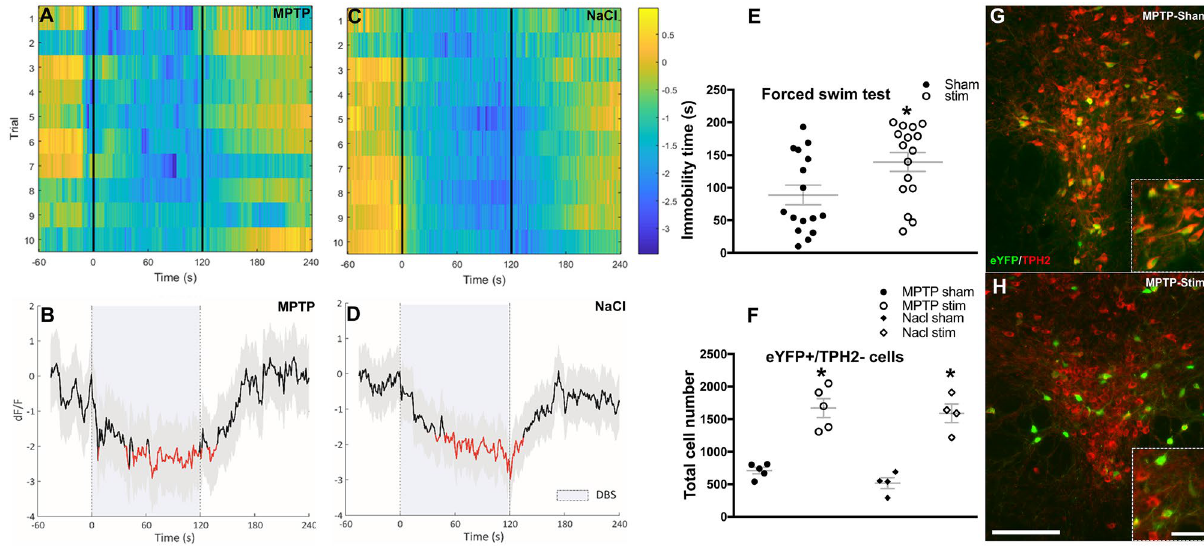
Figure 2. Effect of STN-DBS on serotonergic system. The effect of STN-DBS on activity of 5-HT neurons in the DRN measured with genetically coded calcium sensor GCaMP6s (fiber photometry). ( A ) and ( C ) examples of heat-maps of the change in fluorescence (dF/F) before, during (the stimulation period is indicated by vertical lines), and after DBS in MPTP and NaCl-treated mice, respectively. Each row plots one DBS session (total of 10 trials). Color scale at the right indicates dF/F (yellow = high and dark blue = low dF/F). ( B ) and ( D ) the bottom plots show the cumulative changes in fluorescence averaged over the ten trials in MPTP- ( n = 14) and NaCl-treated mice ( n = 17). The thick black line indicates mean, shaded areas indicate SEM, and red segments indicate statistically significant decrease from baseline (DBS period is indicated by vertical dashed lines; p < 0.05; permutation test). ( E ) STN-DBS induced depressive like-behavior in forced swim test, shown by an increased immobility time in stimulated animals. ( F ) The graph shows that chronic STN-DBS significantly reduced TPH2 expression in transfected (eYFP expressing) cells in both MPTP and NaCl-treated mice. ( G ), ( H ) representative photomicrographs of coronal brain sections containing the DRN display eYFP expressing cells (green) that were double labelled with antibody raised against TPH2 (red; scale bar = 150 µm). Insets in ( G , H ) show higher magnification of eYFP cells that with and without TPH2 labeling (Scale bar = 50 µm). Data are